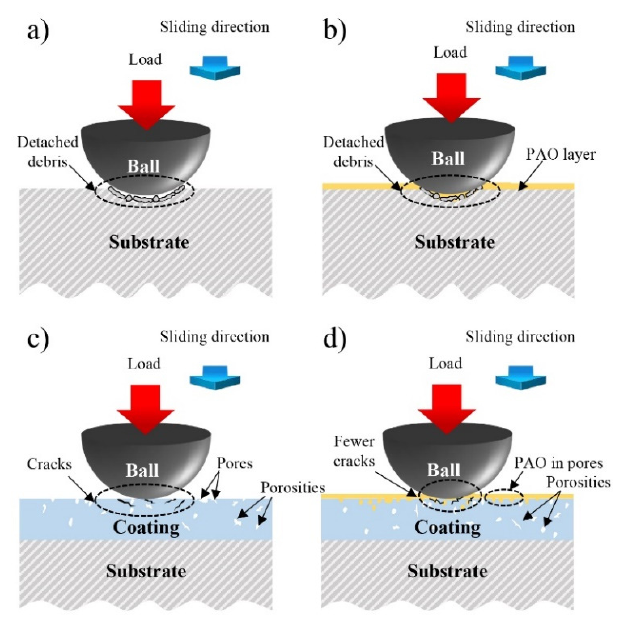
Figure 12. Schematic drawings of wear mechanisms and system details in ball on disc wear test of substrate and coating under both dry and starved lubrication conditions with poly-alpha-olefin (PAO) as lubricant: ( a ) S1, ( b ) S2, ( c ) C1, ( d ) C2.